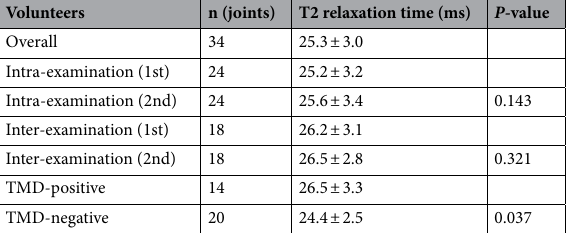
Table 2. T2 relaxation times of the articular disc. TMD, temporomandibular disorders.